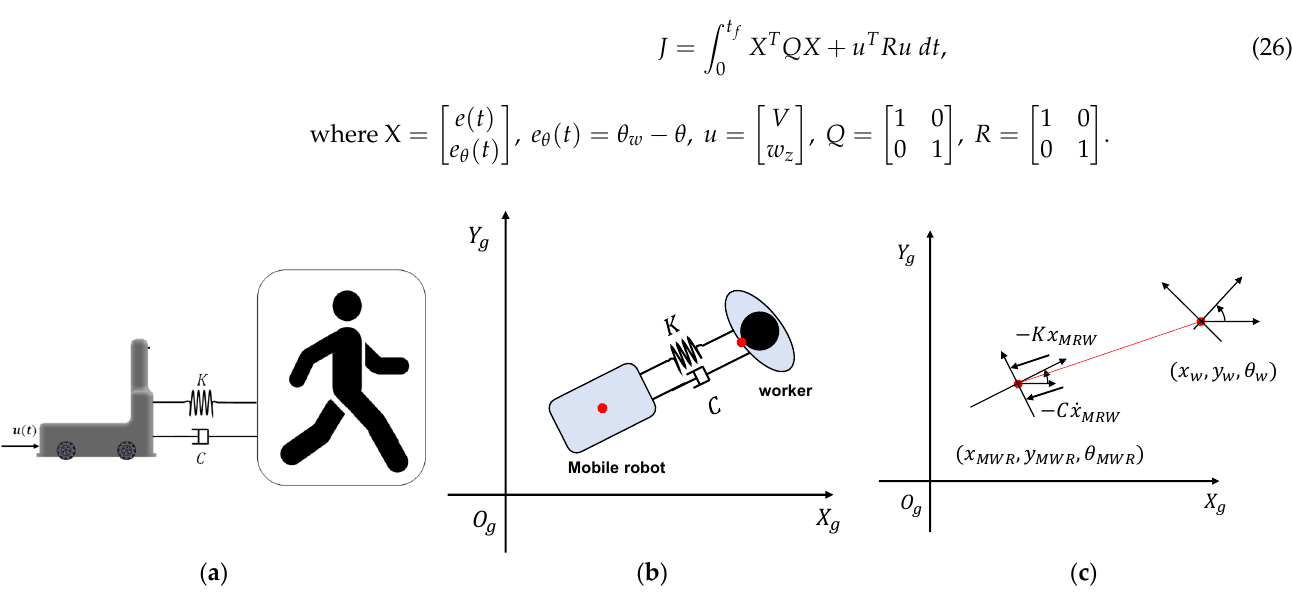
Figure 8. Relative motion of the worker and mobile robot. ( a ) Lateral view; ( b ) Vertical view; ( c ) Vertical view (point mass).